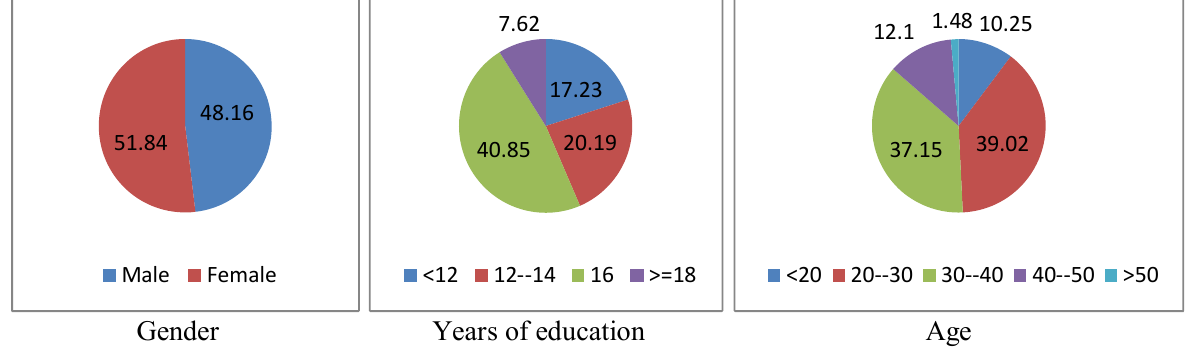
Fig. 2. Personal characteristics of the participants